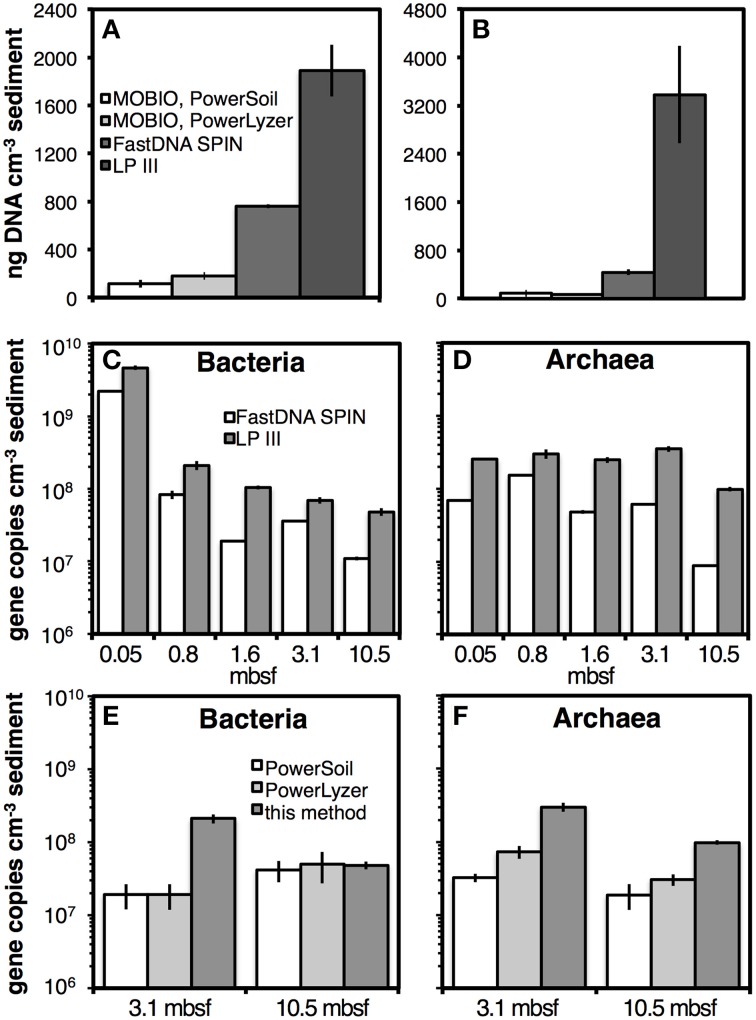
DNA yield comparisons of our extraction method using LP III to commercial DNA extraction kits by MO BIO (PowerSoil, PowerLyzer) and/or MP Biomedicals (FastDNA SPIN). Quantifications were by fluorescence spectroscopy for Aarhus Bay Station M5 (A) and Aarhus Bay Station MIMOSA (B). Quantifications were by qPCR of 16S rRNA genes on samples from Aarhus Bay Station M1 (C–F). Five depths, from surface sediments to 10.5 mbsf were used for comparisons to the FastDNA SPIN kit (C,D). Two samples were used for comparisons to both MO BIO kits (E,F). Bead-beating was performed in extractions with the FastDNA SPIN kit and MO BIO PowerLyzer kit. Sediment samples from Station M5 and MIMOSA were both methanogenic and from 1.2 mbsf. Sediment samples from Station M1 were from 0.05, 0.8, 1.6, 3.1, and 10.5 mbsf, which corresponded to bioturbated surface sediment, sulfate reducing sediment, the sulfate-methane transition zone, methanogenic marine sediment, and a methanogenic soil layer, respectively. Error bars indicate standard deviations of extractions that were run in triplicate.